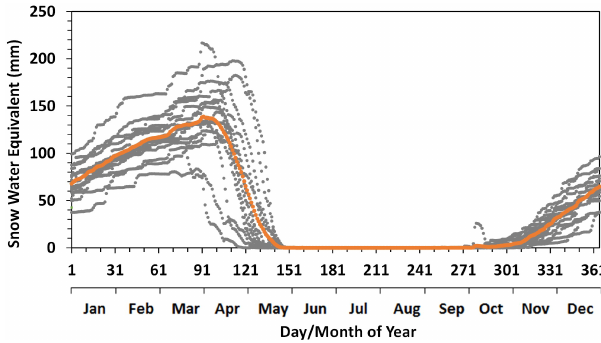
Figure 2. Daily air temperature for the Albany River watershed over the study period (2002–2016). Orange dots represent the 15-year mean values.